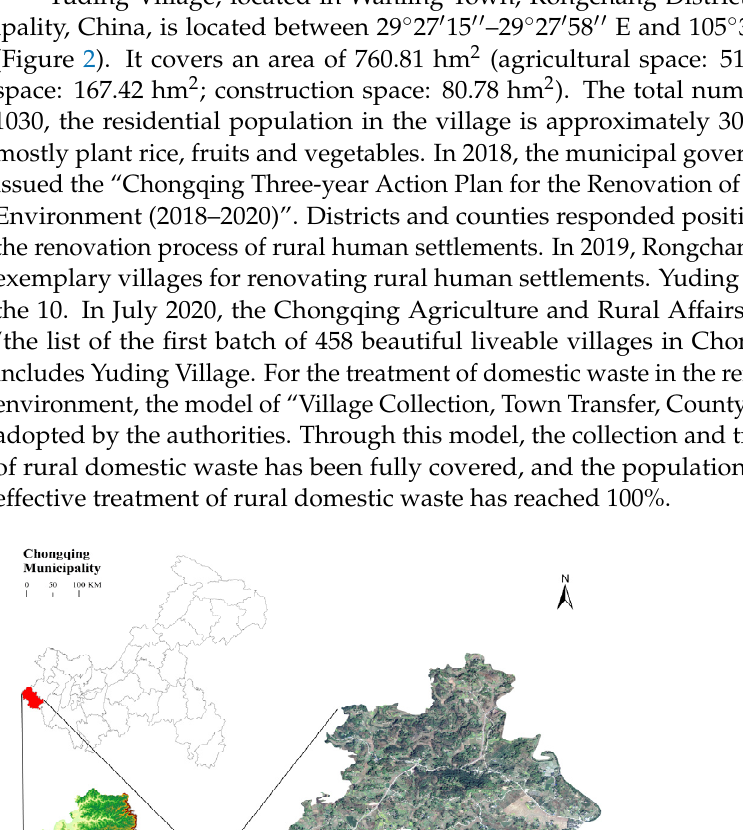
Figure 1. Research framework for garbage bin layout optimisation based on ANT.